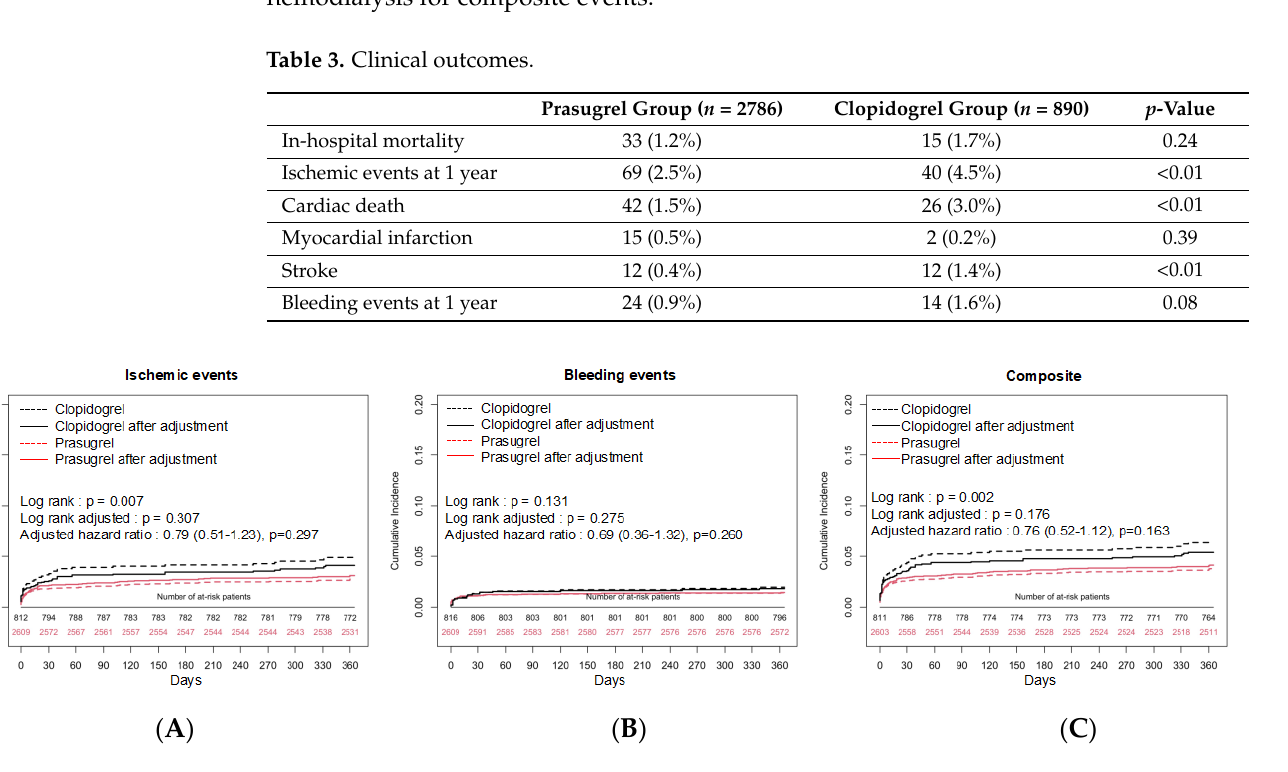
Table 3. Clinical outcomes.